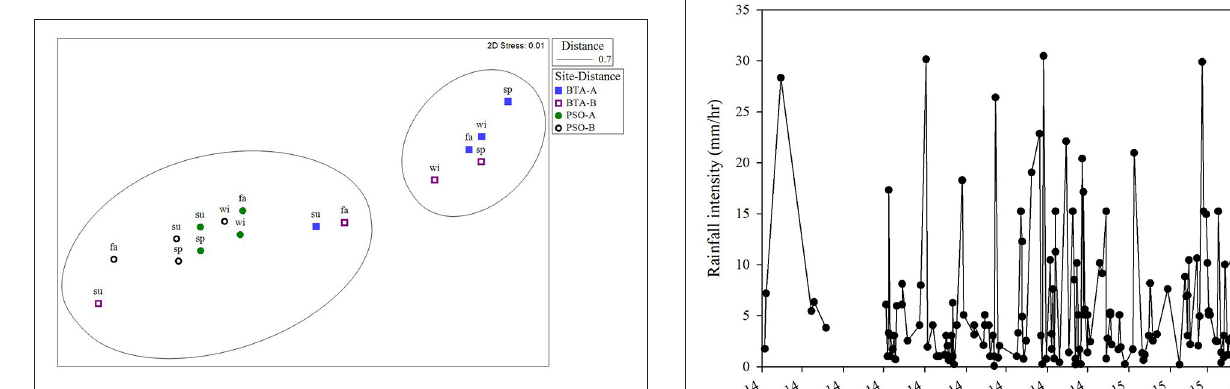
FIGURE 9 | Non-metric multidimensional scaling (nMDS) plot for terrigenous content by time, sites and distance zone from shore. Clusters based on a Euclidean distance cutoff level of 0.70. Ordination diagram shows terrigenous content on first two dimensions, X axis (nMSD1) and Y axis (nMDS2). Seasons are represented as sp, spring; su, summer; fa, fall; wi, winter.